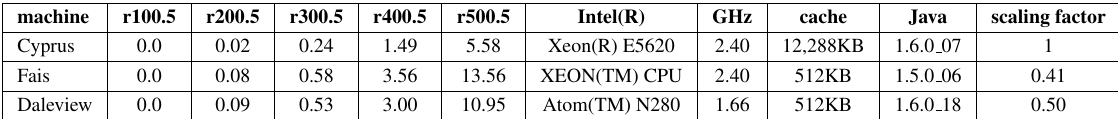
Table 7. Conversion factors using dfmax on three machines: Cyprus, Fais and Daleview. machine